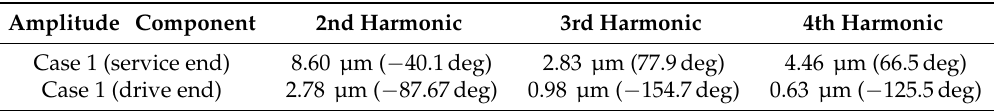
Table 2. Average amplitudes and phases of the two roller element paths (see Figure 5) used in Case 1 for the service end and the drive end. For the phase, the circular average was